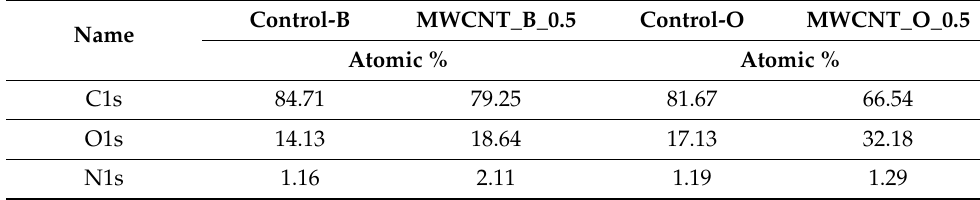
Table 7. C, O, and N atomic concentration on the leather surface.